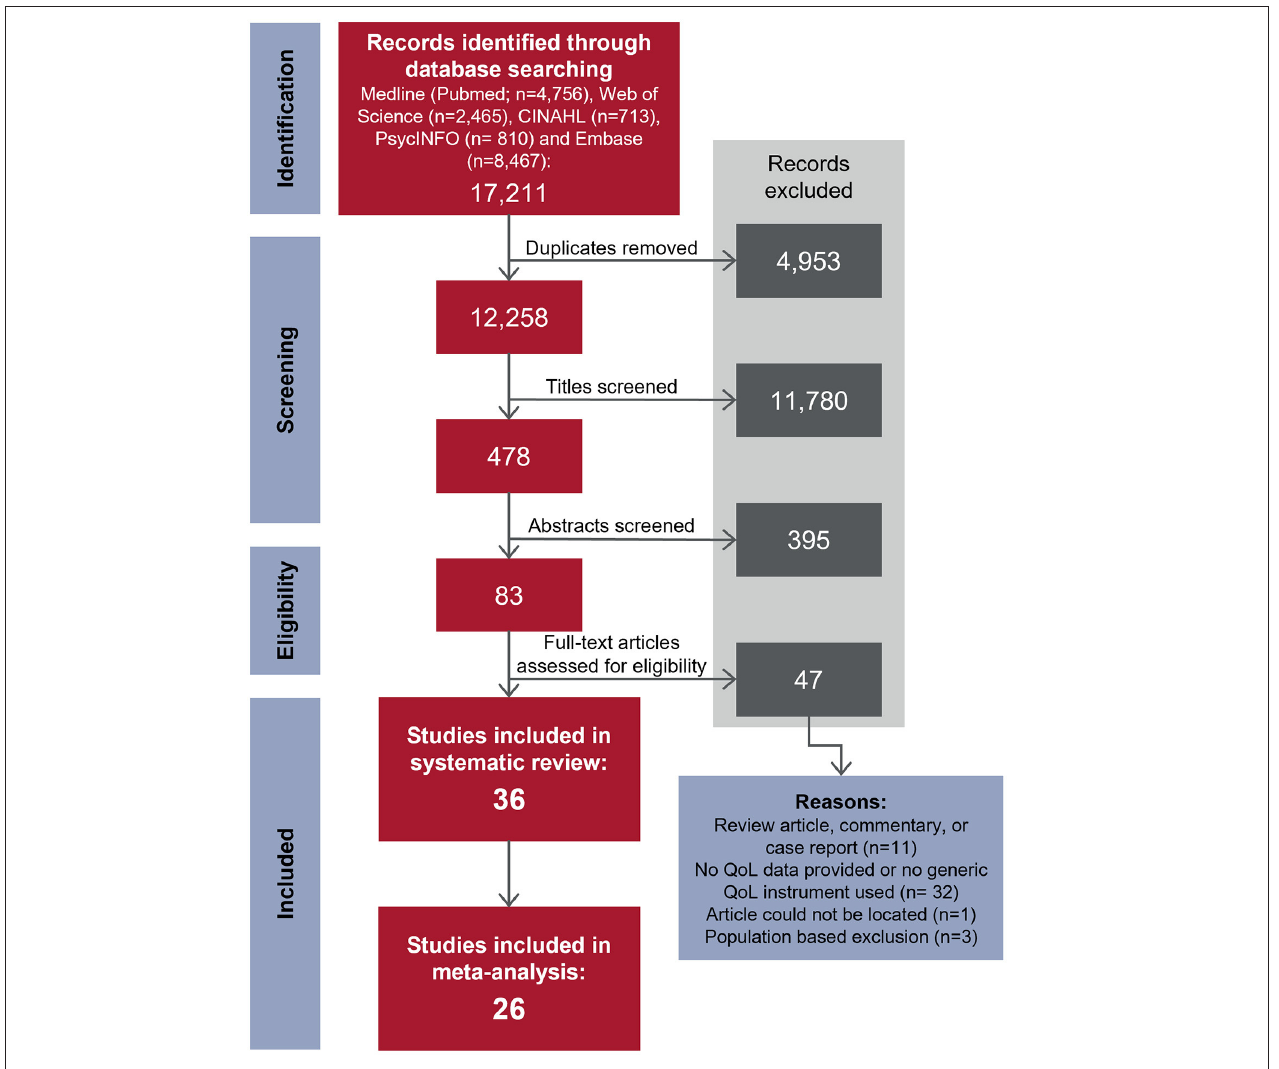
FIGURE 1 | Flowchart depicting the study selection process. Studies were selected for inclusion using a two-stage approach. In stage one (screening), titles, then abstracts were screened to select studies published in peer-reviewed journals that investigated patients with syncopal disorders and provided an indication that quality of life was evaluated as an outcome measure. The emphasis at this stage was on excluding articles that were clearly unrelated to the research question. In stage two (eligibility), full-text papers for stage one inclusions were obtained and inclusion and exclusion criteria were firmly applied. Reasons for exclusion were recorded in the second stage of the study selection process. Adapted from PRISMA statement (2009)